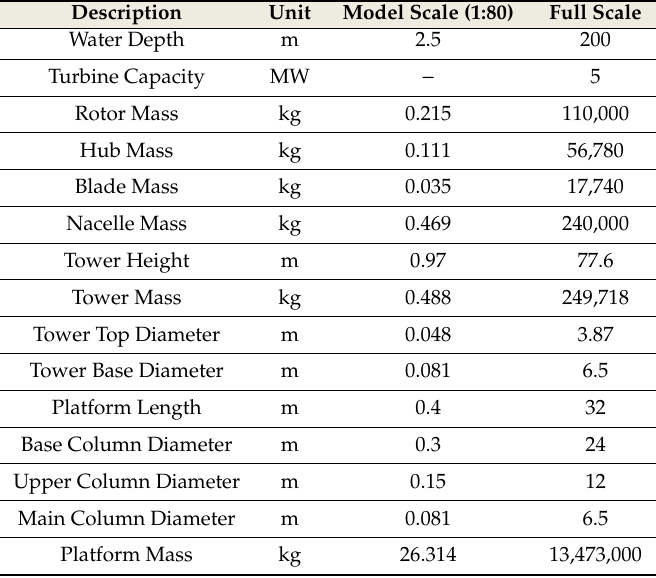
Figure 3. FAST-UOU structure.